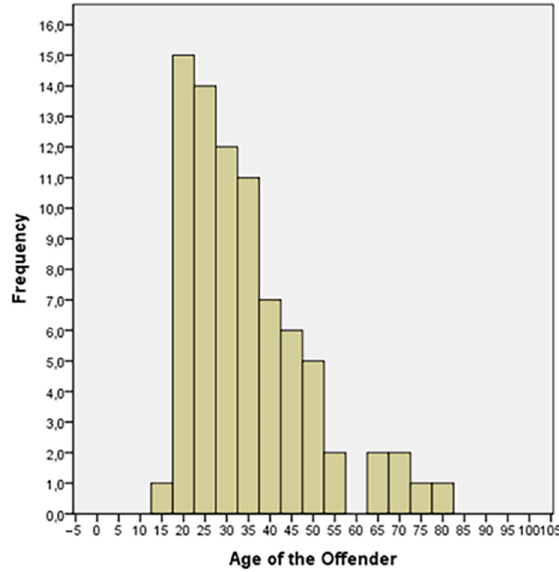
Figure 2. Age distribution of the